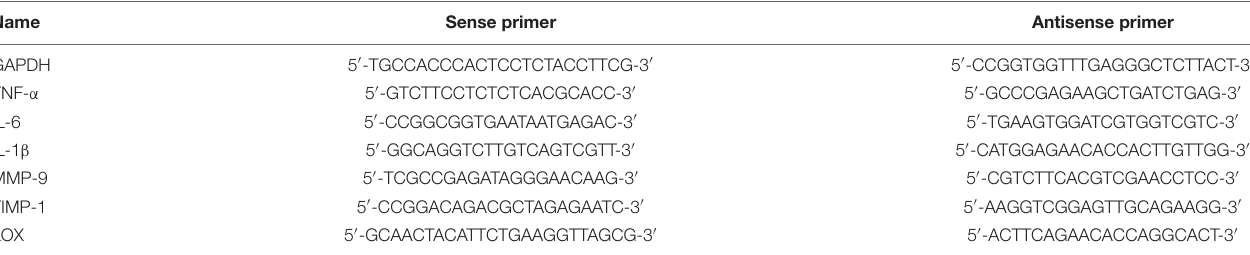
TABLE 1 | Rabbit sequences of primers used for quantitative real-time